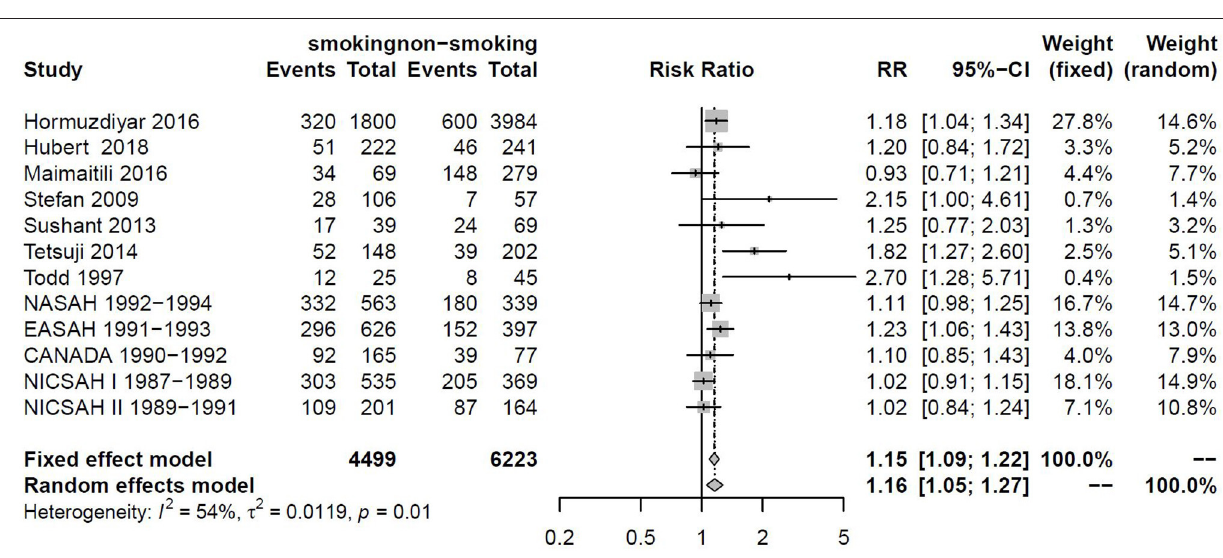
FIGURE 2 | Forest plot of the smoking as one of the risk factors for